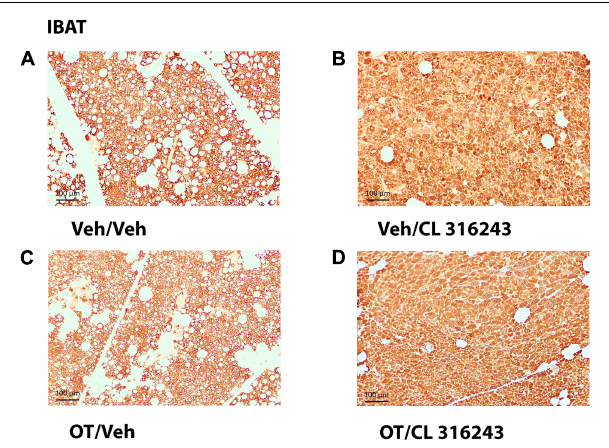
FIGURE 8 | (A–D) Effect of chronic 4V OT infusions (16 nmol/day) and systemic beta-3 receptor agonist (CL 31643) administration (0.5 mg/kg) on UCP-1 content in IBAT in male DIO rats. UCP-1 staining was quantified in IBAT from DIO rats that received chronic 4V infusion of OT (16 nmol/day) or vehicle in combination with daily CL 316243 (0.5 mg/kg) or vehicle treatment ( N = 7–10/group). (A) Veh/Veh. (B) Veh/CL 316243. (C) OT/Veh. (D) OT/CL 316243. (A–D) All visualized at 100 ×